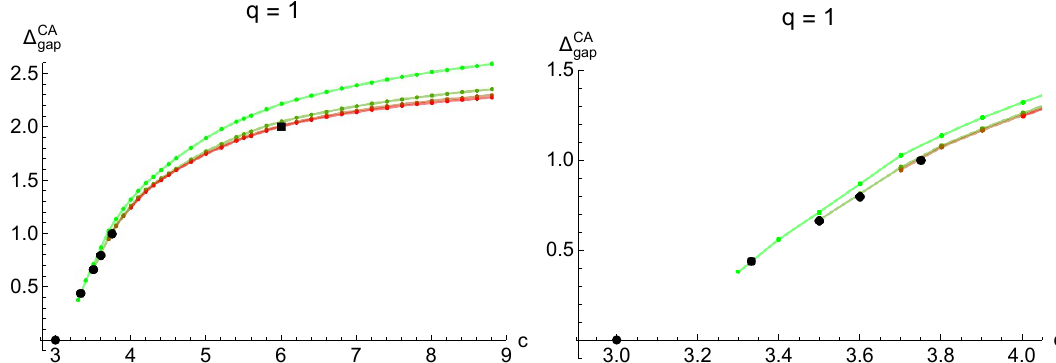
Figure 4. Left: upper bounds on the gap in the CA channel (cid:1) CA tion (2.13) on the gap in the CC channel (cid:1) CC orders 4 ; 8 ; 12 ; 16 (from green to red). Right: the same plot zoomed into 3